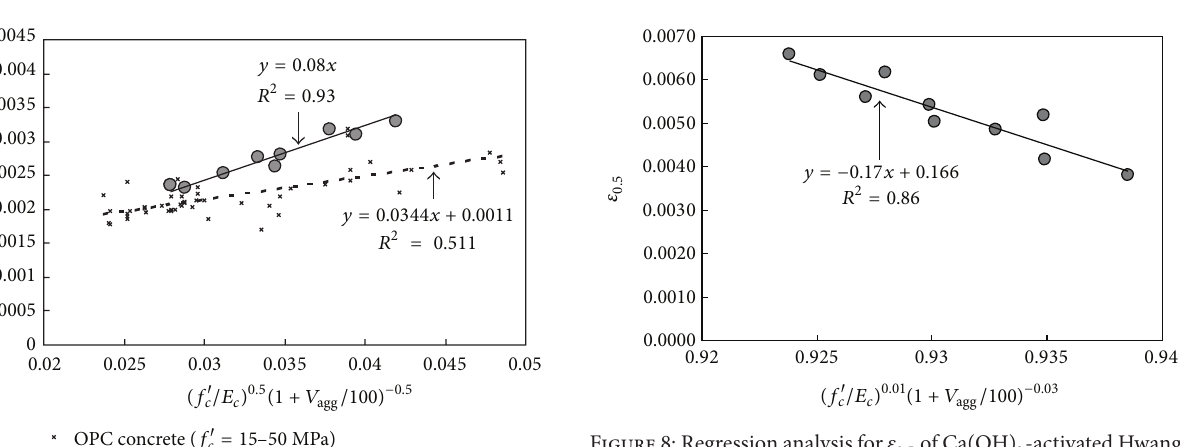
Figure 8: Regression analysis for 𝜀 0.5 of Ca(OH) 2 -activated Hwang- toh